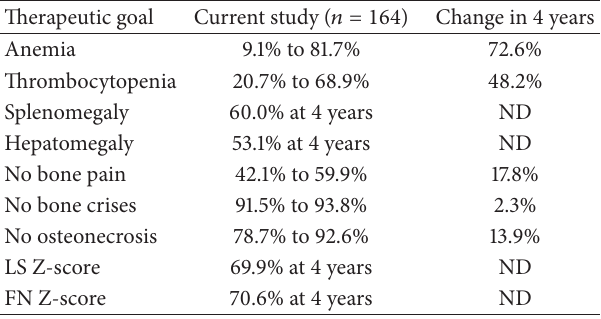
Table 3: Percent of patients achieving therapeutic goals in 4